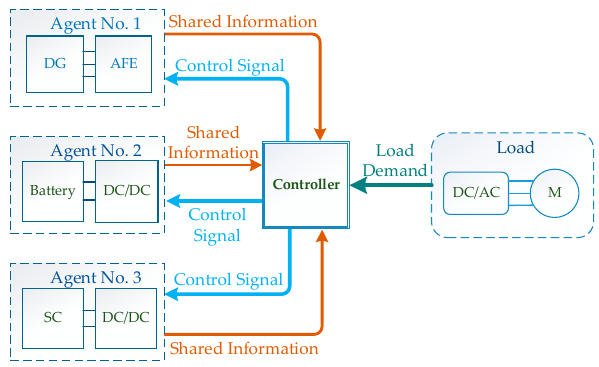
Figure 7. Schematic of the proposed energy management method.